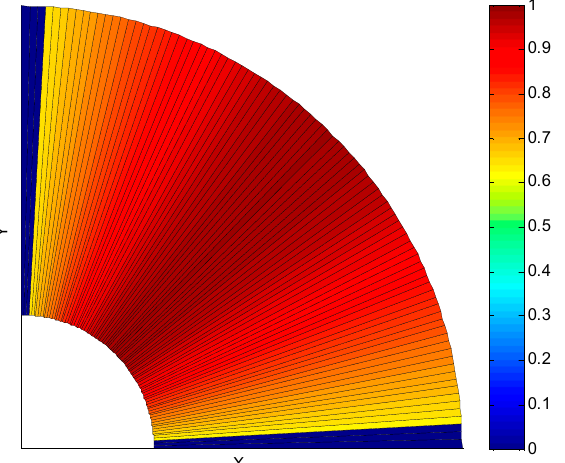
Figure 3. Distribution of the orientation weight in Cartesian coordinates.